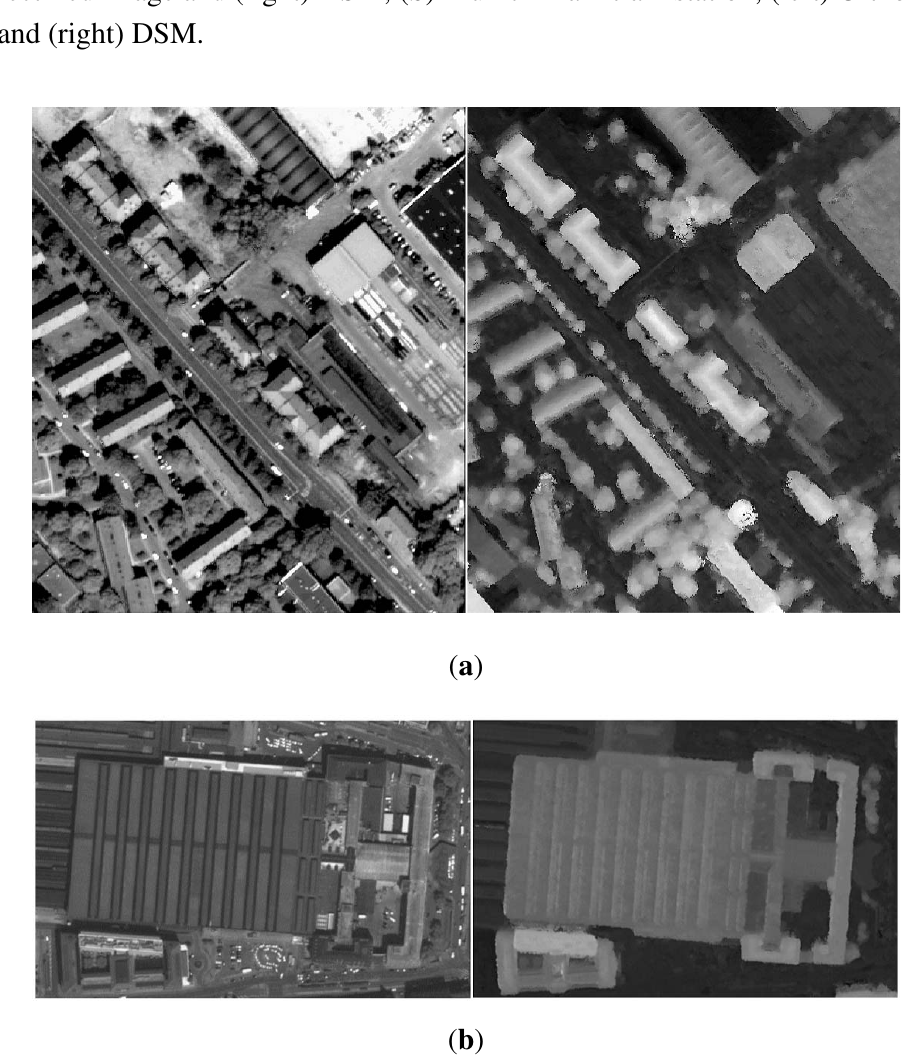
Ortho-rectified Worldview-2 (left column) versus DSM produced from Worldview-2 stereo satellite images (right column) Munich. ( a ) Munich city center; (left) Ortho-rectified image and (right) DSM; ( b ) Munich main train station; (left) Ortho-rectified image and (right)